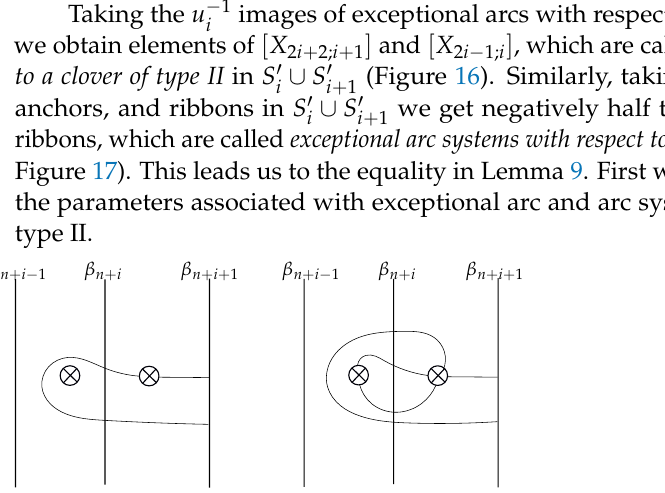
images of exceptional arcs of type I give exceptional arcs of type II. Figure 16. u − 1 i